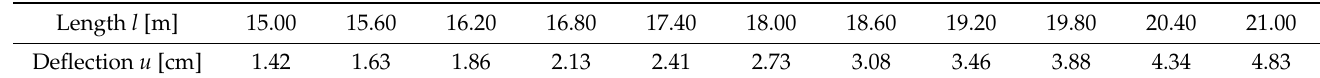
Figure 5. The polynomial response function of the truss deflection depending upon its span. Table 2. Truss deflection and its span interdependence—numerical results.